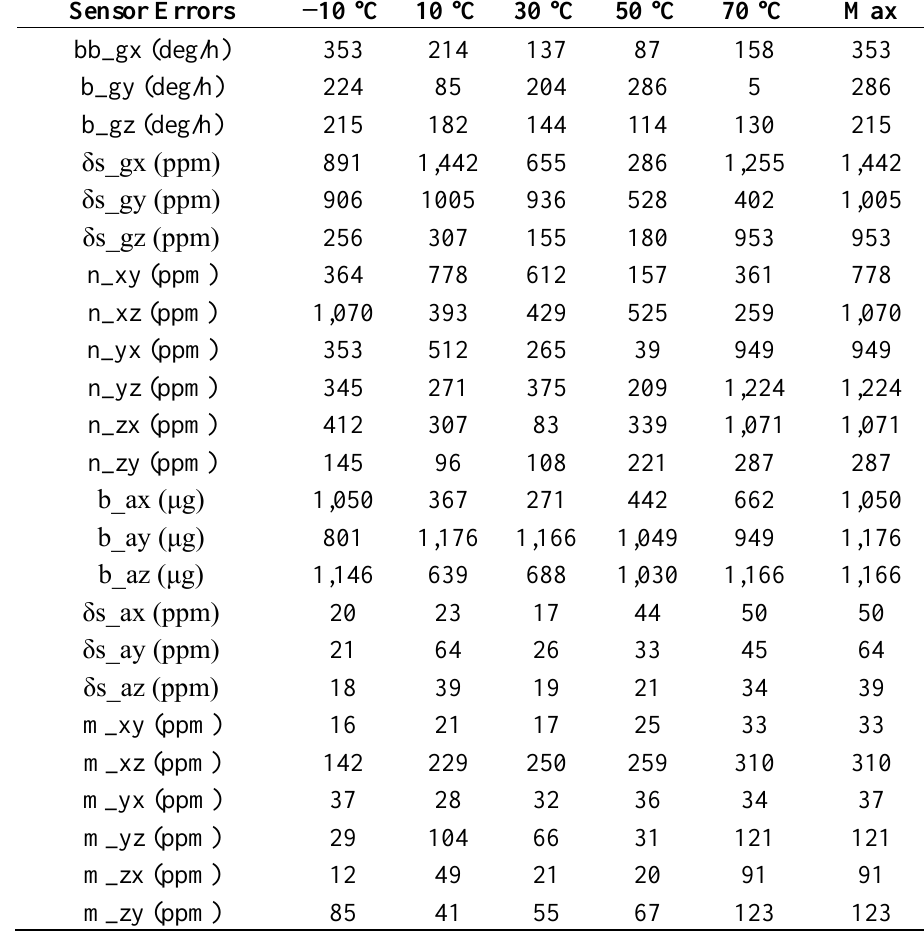
Table 4. Errors (RMS) of MTi-G thermal calibration at typical temperature points (using the results of the Soak method as